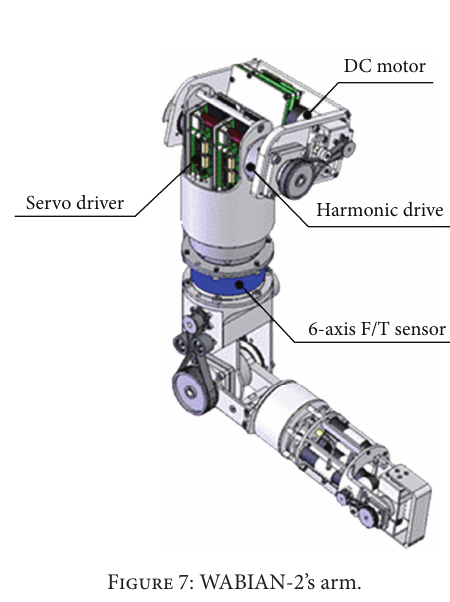
Figure 7: WABIAN-2’s